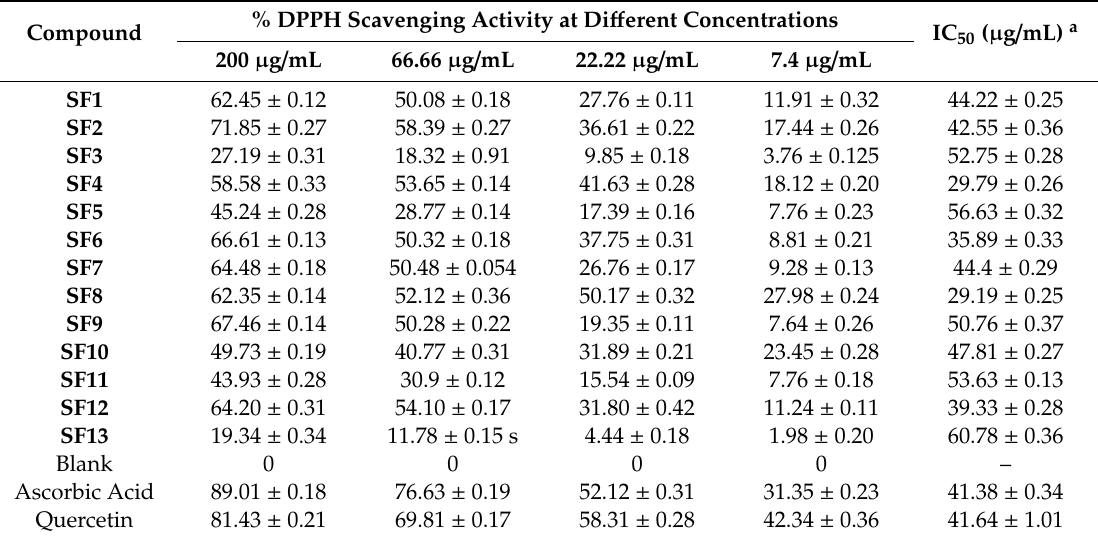
Table 2. DPPH free radical scavenging activity of synthetic compounds with IC 50 values.